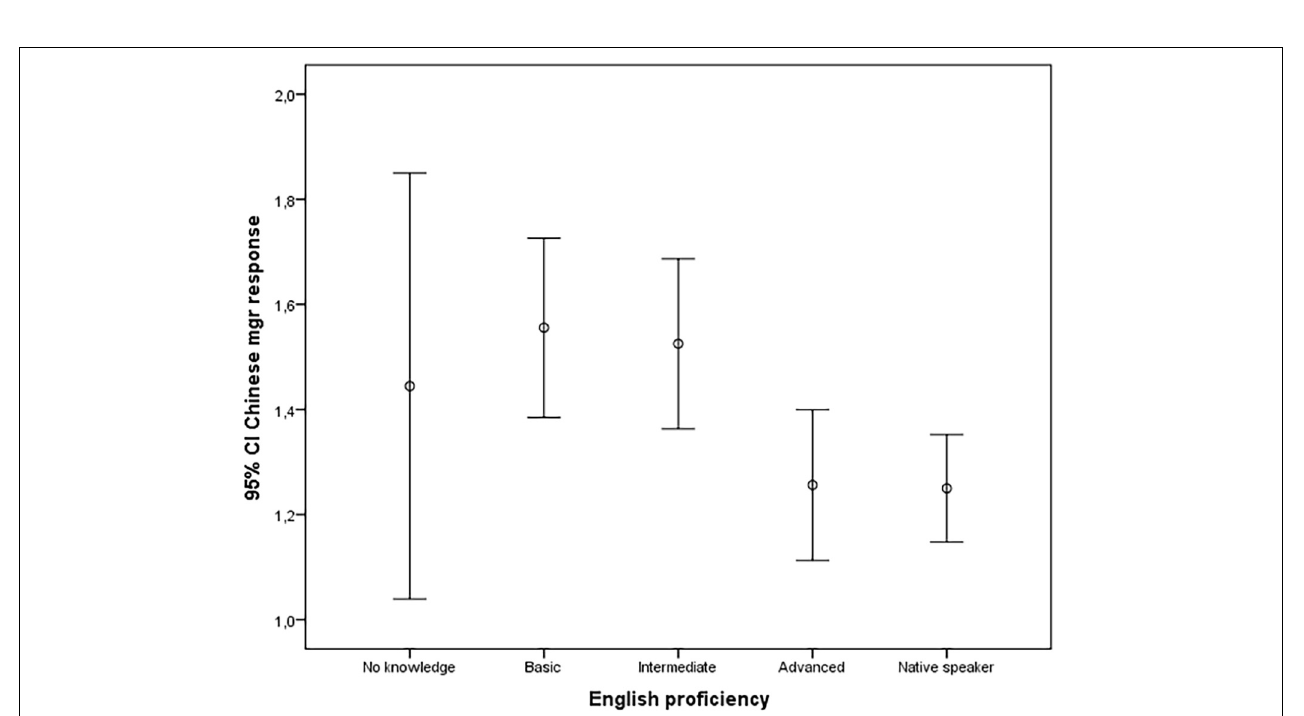
FIGURE 2 | The relationship between proficiency in English language and the tendency to guess the most likely outcome of the scenario.